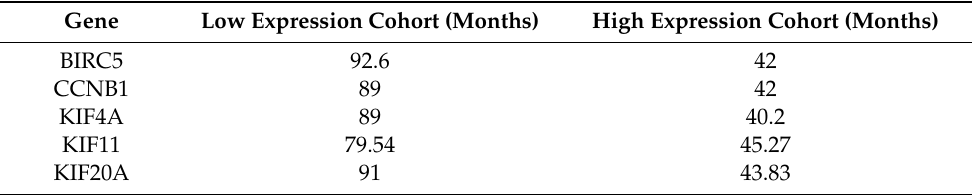
Table 1. Median survival time in di ff erent expression cohorts with respect to each hub gene. Gene Low Expression Cohort (Months) High Expression Cohort (Months) BIRC5 92.6 42 CCNB1 89 42 KIF4A 89 40.2 KIF11 79.54 45.27 KIF20A 91 43.83